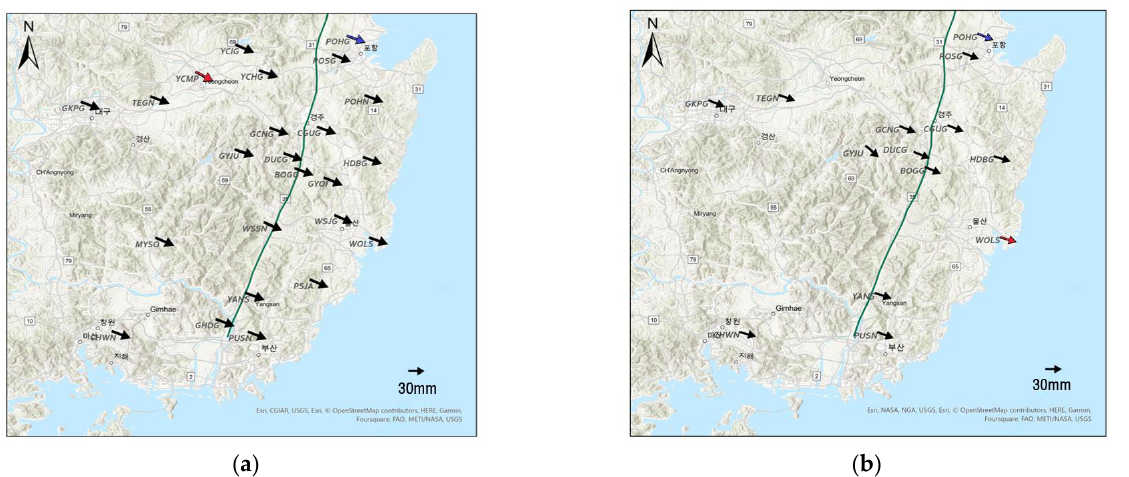
Figure 4. ( a ) Displacement of station in 2018 – 2019; ( b ) displacement of station in 2020 – 2021. Red is the largest station moved, and blue is the least moved station.